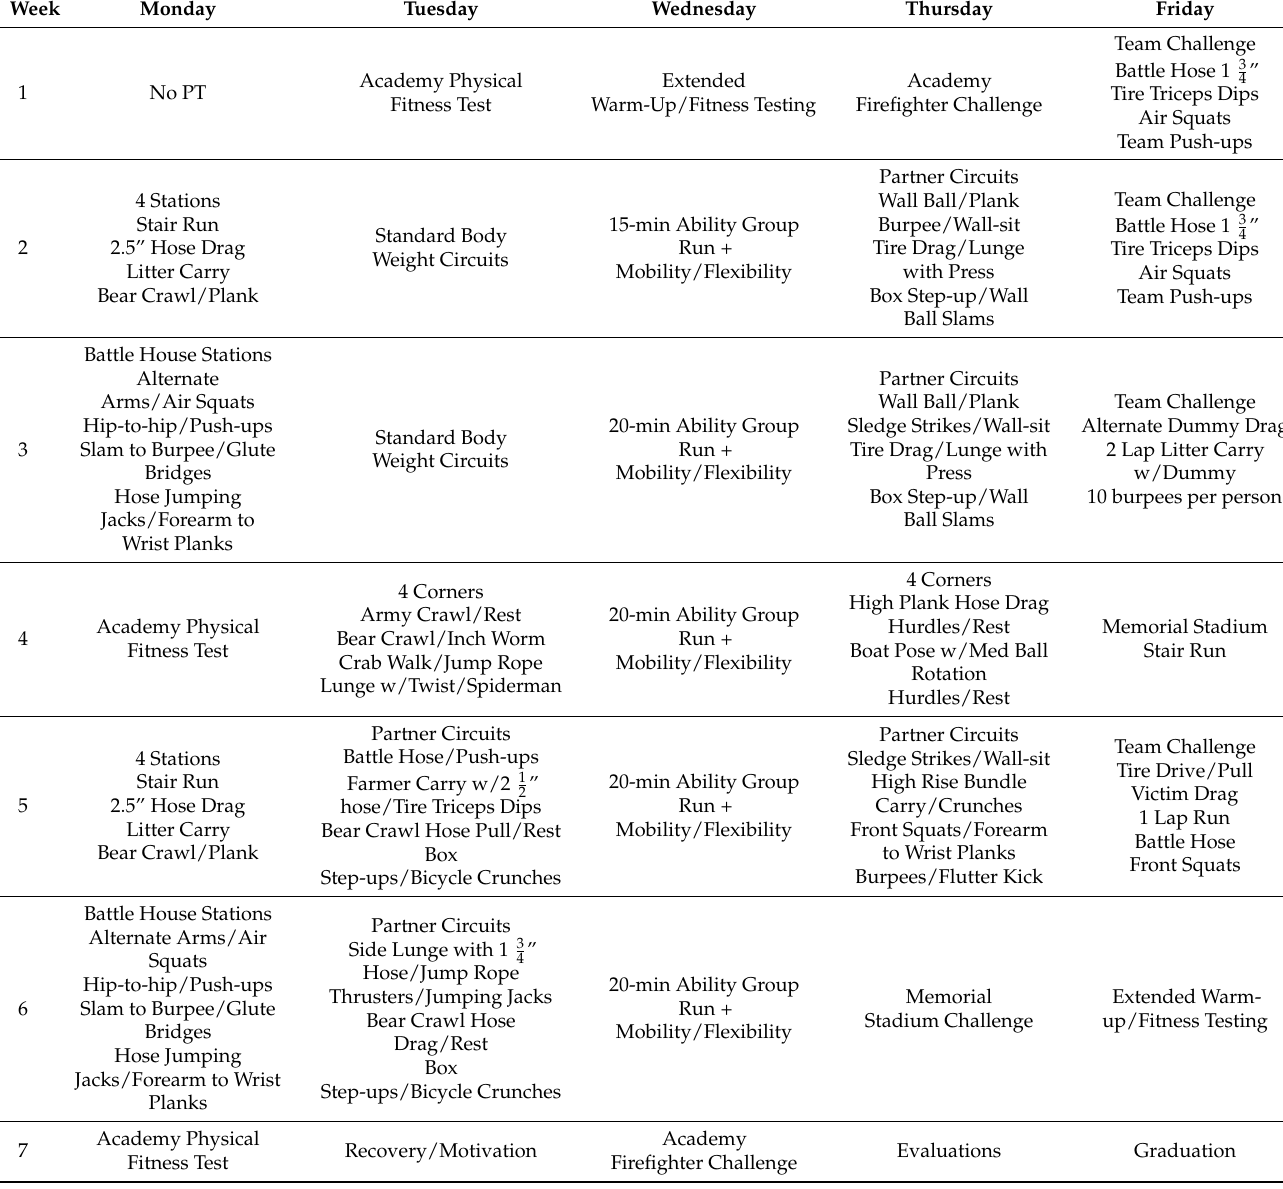
Table 2. Tentative Academy HIFT